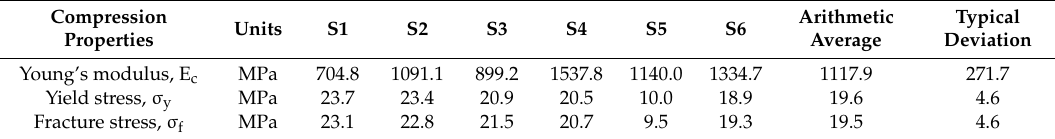
Table 8. Elastic and mechanical properties of PETG for each X-axis specimen.